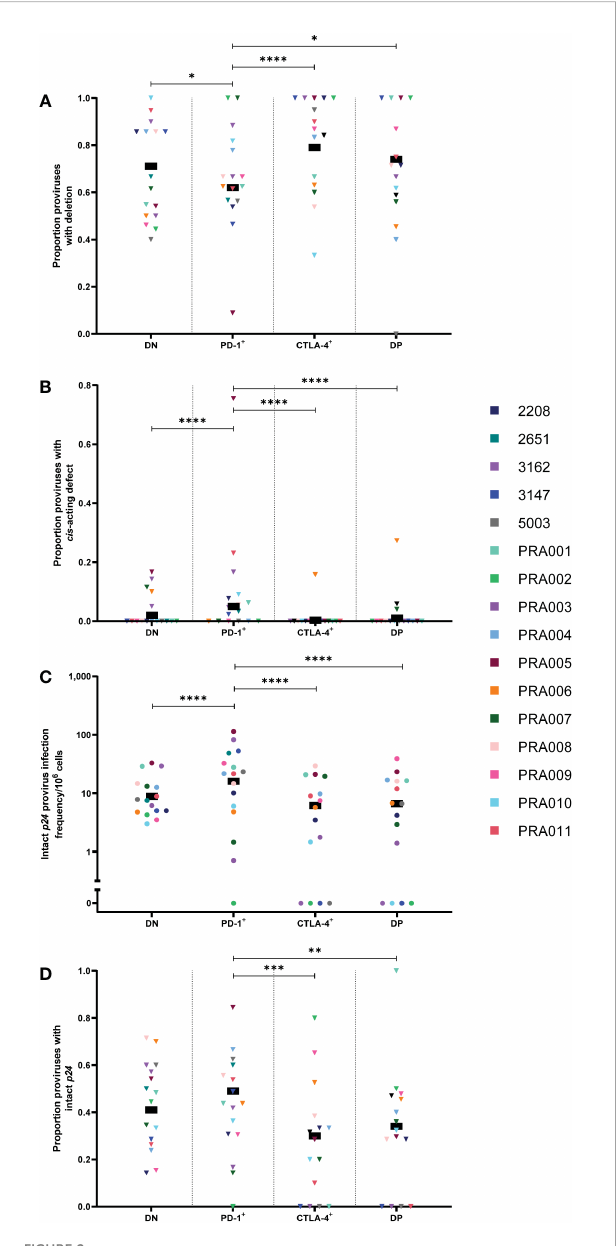
FIGURE 2 HIV-1 proviruses with an intact p24 open reading frame in peripheral blood memory CD4 + T-cells expressing PD-1 and/or CTLA-4. The proportion of ampli fi ed proviruses that contained either a large internal deletion (A) or a mutation in the cis -acting region (B) from DN, PD-1 + , CTLA-4 + and DP cells. The HIV-1 infection frequency per 10 6 cells of proviruses with an intact p24 ORF in DN, PD-1 + , CTLA-4 + and DP cells (C) . The proportion of ampli fi ed proviruses that contained an intact p24 ORF in DN, PD-1 + , CTLA-4 + and DP cells (D) . Data is the estimated infection frequency per 10 6 cells or proportion for each subset. p-values represent evidence for an overall trend of a difference between subsets within these participants (mixed effects logistic regression), * p ≤ 0.05, ** p ≤ 0.01, *** p ≤ 0.001, **** p ≤ 0.0001.